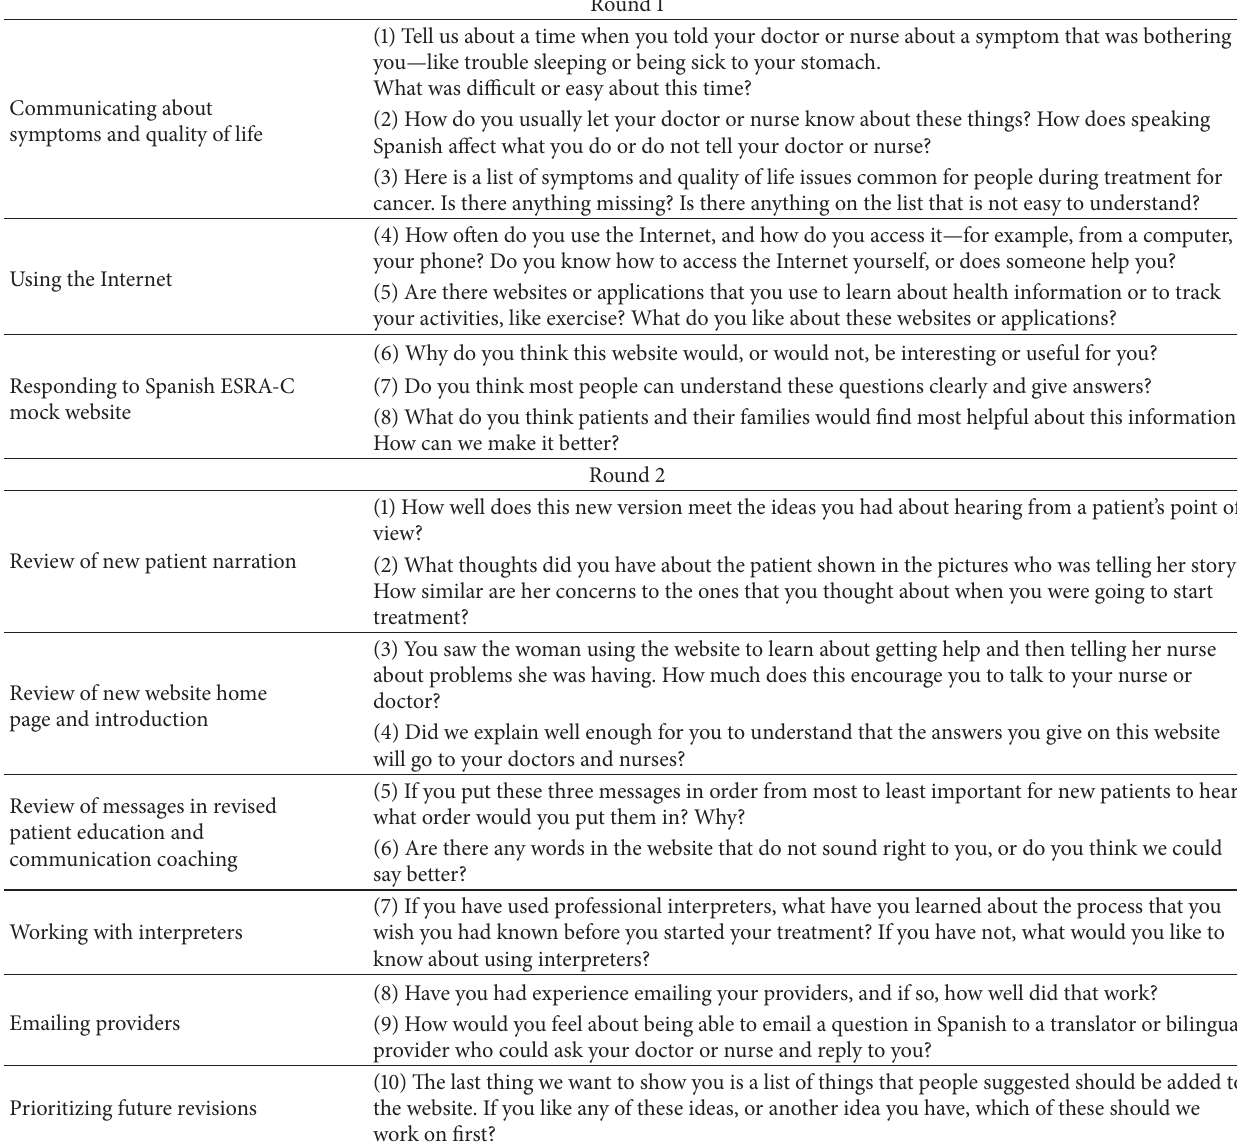
Table 1: Focus group interview topics and prompts. Round